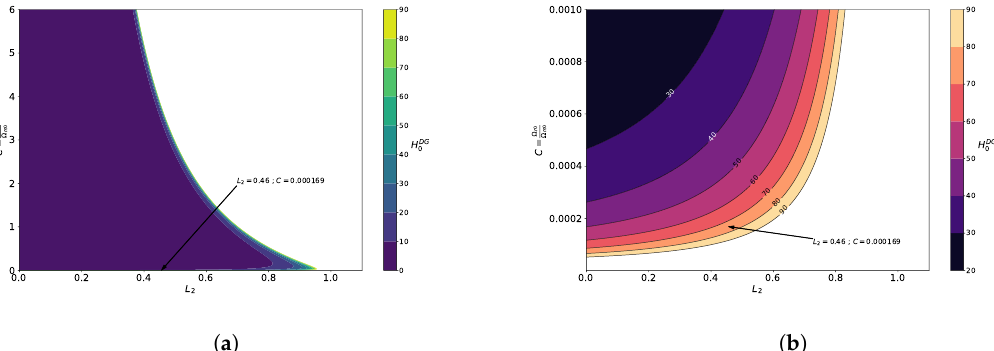
Figure 12. H DG for a different combination of L 2 and C values. The fitted values found by MCMC 0 analysis is indicated in the Figure. ( a ) C values go from 0 to 6 to explore various Universes, even a Universe wholly dominated by radiation. ( b ) The C values are bounded to very little values, nearly close to the C fitted value obtained by MCMC.